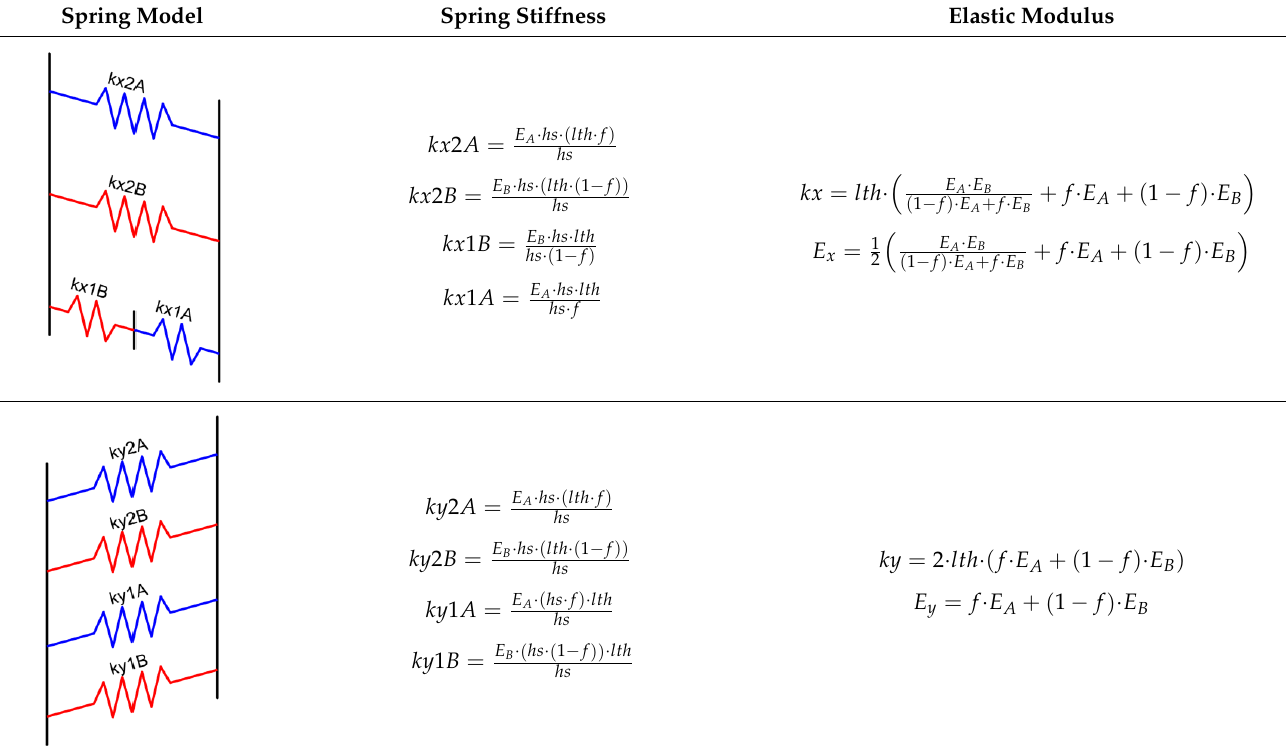
Figure 4. Volume element of deposited material: the first layer is deposited in the y-direction, whereas the second layer is deposited in the x- direction. Blue represents a generic “A material”, and red represents a generic “B material”. In ( a ), the volume element is made up of 25% of the “A mate- rial” and 75% of the “B material”, in ( b ), there is 50% of “A” and 50% of “B”, and in ( c ), there is 75% of “A” and 25% of “B”. Simplified model for elastic modulus estimation: ( d ) flipped material ex- truded along the x-positive direction; ( e ) reduced length.